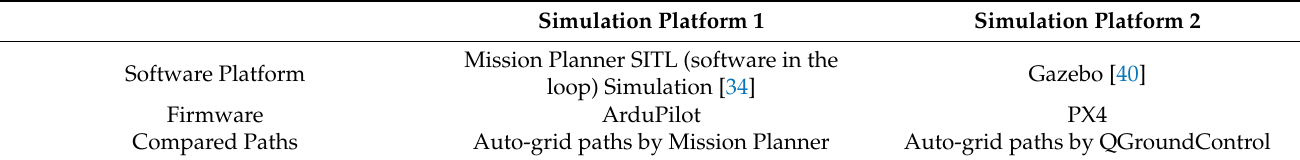
Table 1. Simulation